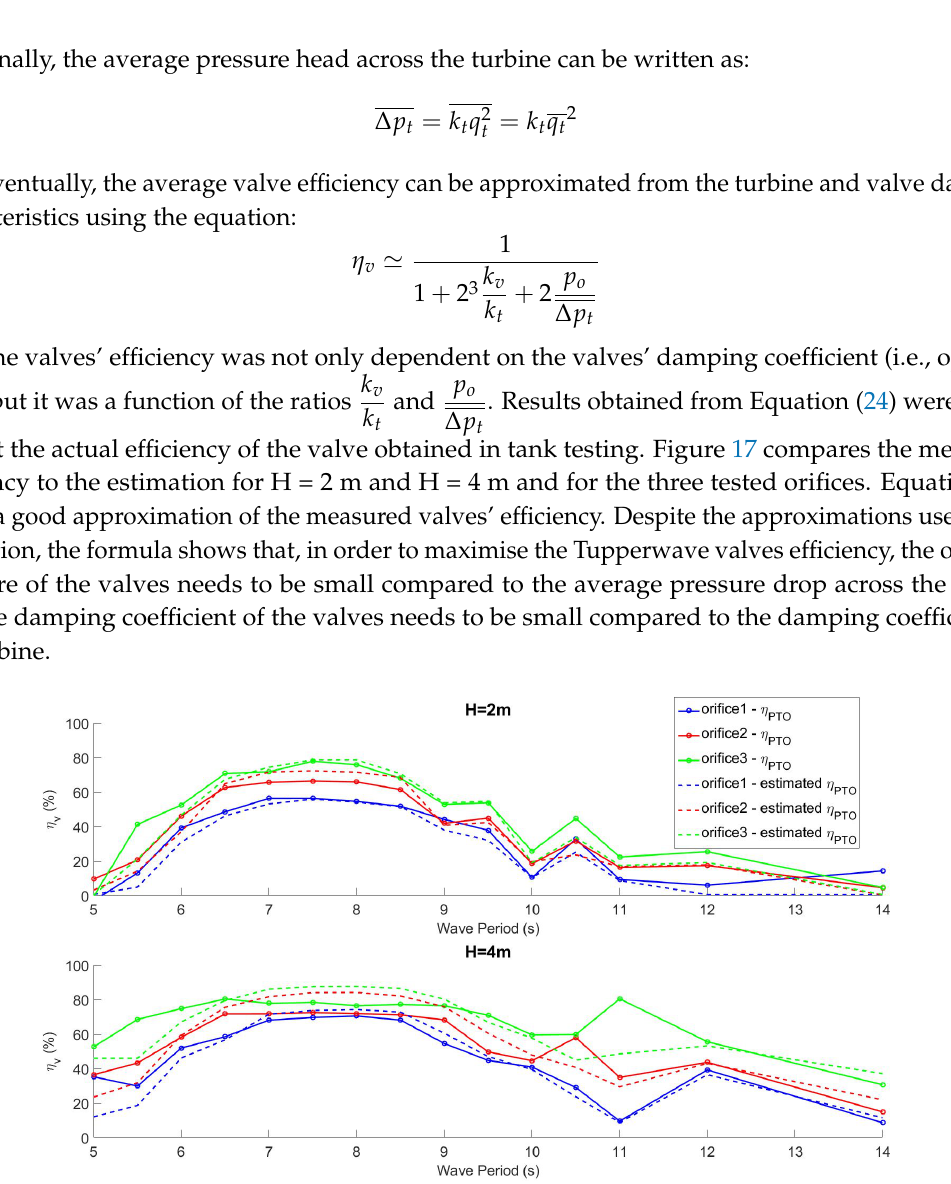
Figure 17. Valve efficiency obtained in regular waves compared to the efficiency estimated via Formula